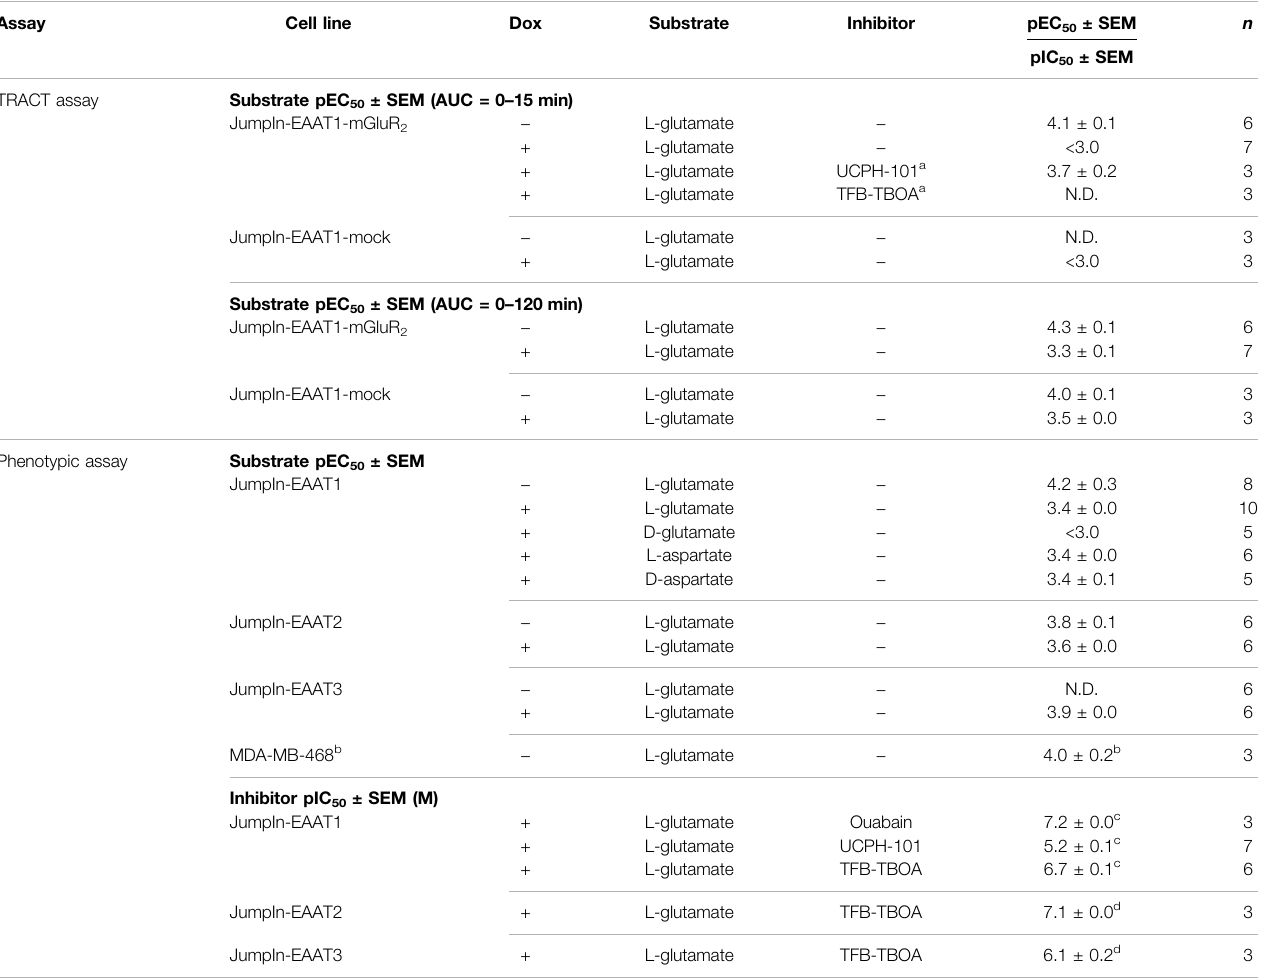
TABLE 1 | List of ( − log) potency (pEC 50 ) and inhibitory potency (pIC 50 ) values of EAAT substrates and inhibitors on various cell lines in the TRACT and phenotypic assays. Potencies were determined on non-induced ( − ) or doxycycline (dox)-induced (+) cells in the absence ( − ) or presence of an inhibitor by analyzing the net area under the curve (AUC) of the fi rst 120 min after substrate stimulation (unless stated otherwise). pIC 50 values are written in italic. N.D. = not determined. Assay